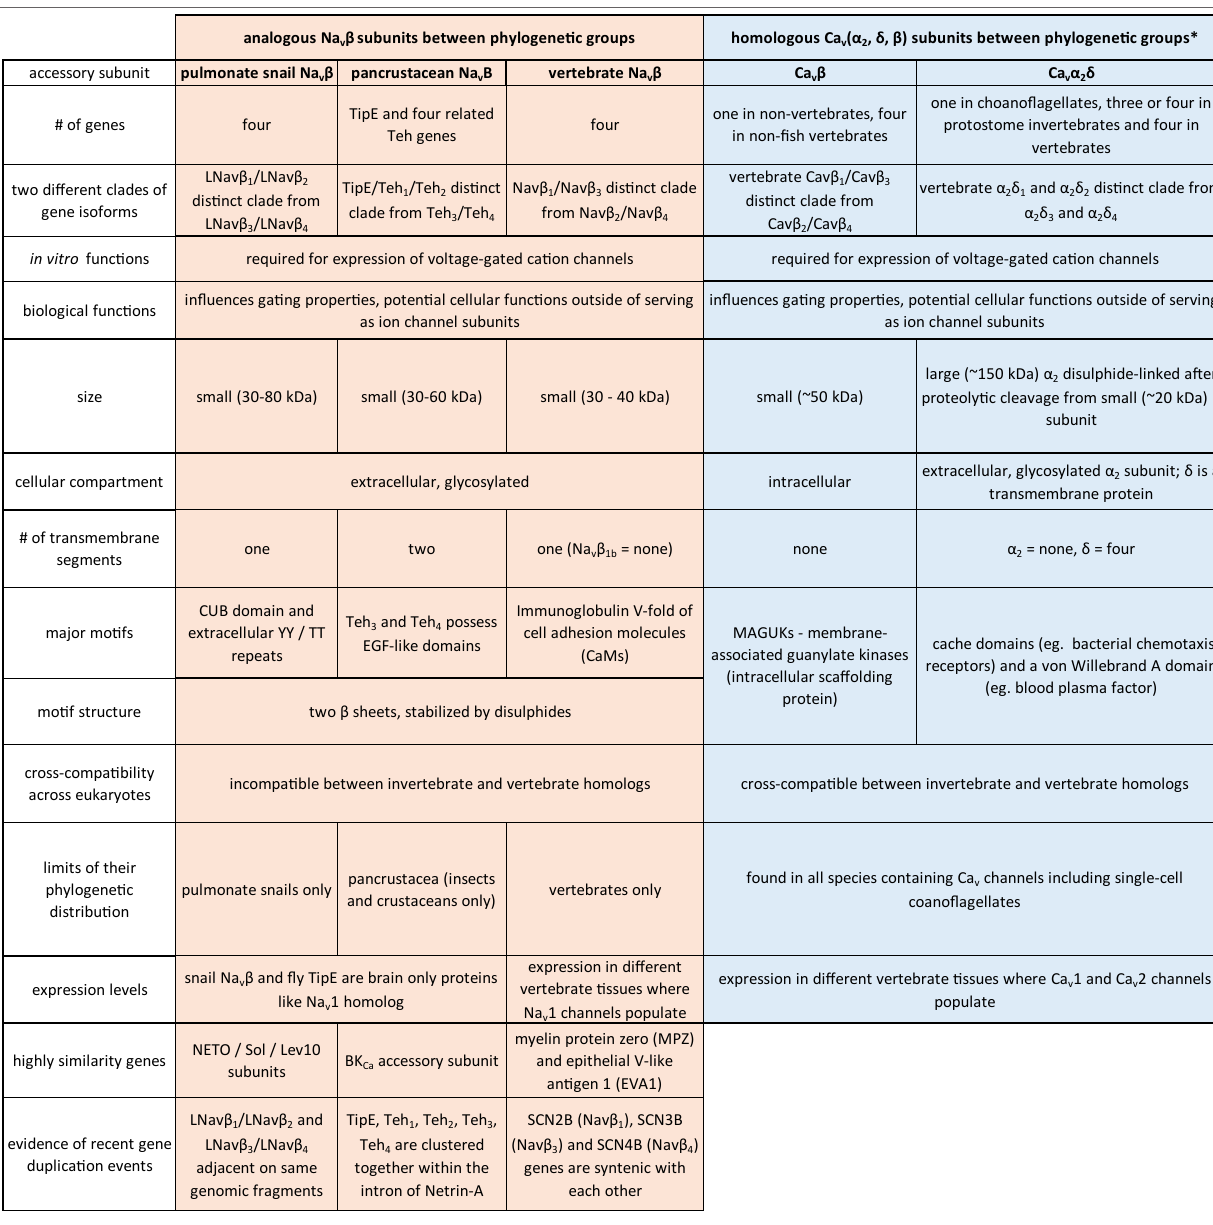
TABLE 1 | Comparisons between sodium and calcium channel accessory subunits # .